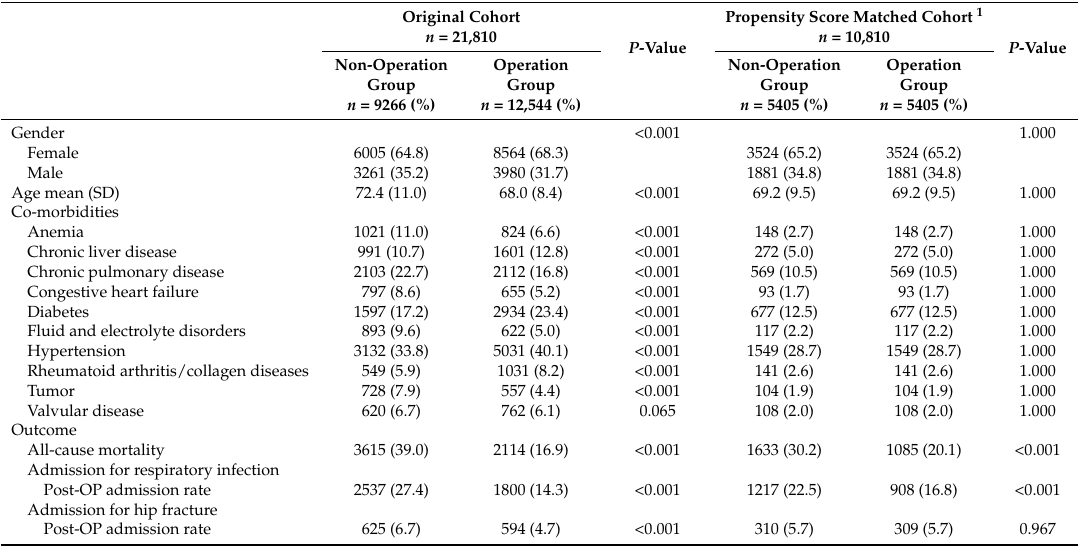
1 Propensity scores were calculated using multiple logistic regression, with sex, gender, and 10 co-morbidities listed. Patients in the operation and non-operation groups were matched closely with a very low matching tolerance (matching caliber = 0.0001) to evaluate treatment effect of the operation for spinal